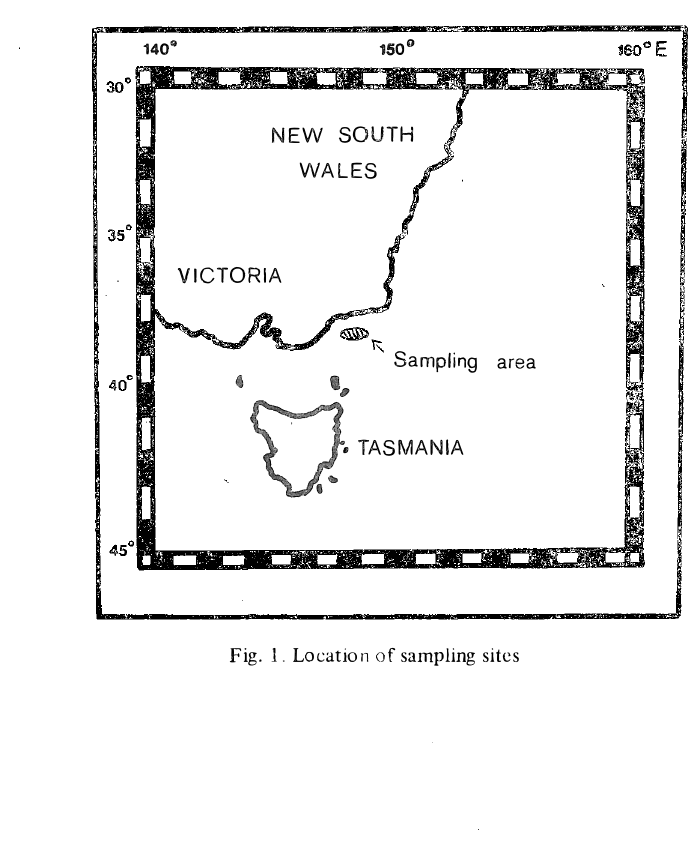
Fig. 1. Location of sampling